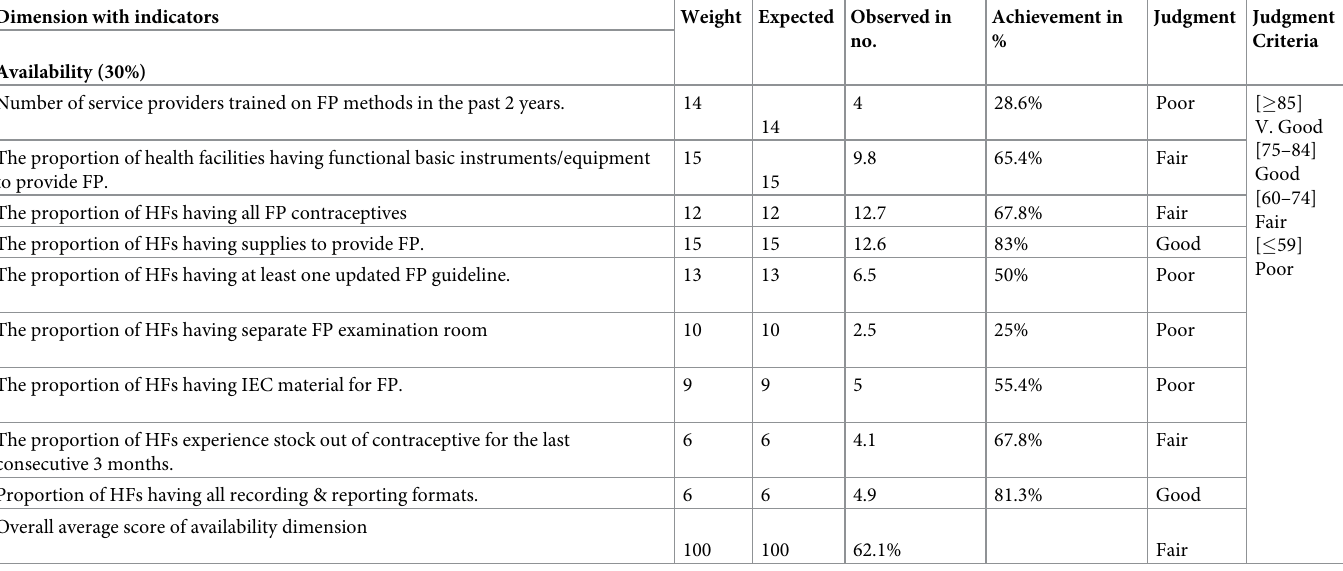
Table 2. Judgment matrix of availability dimension to provide family planning service in Gondar city administrative public health facilities, Northwest Ethiopia, 2020. Dimension with indicators Weight Expected Observed in